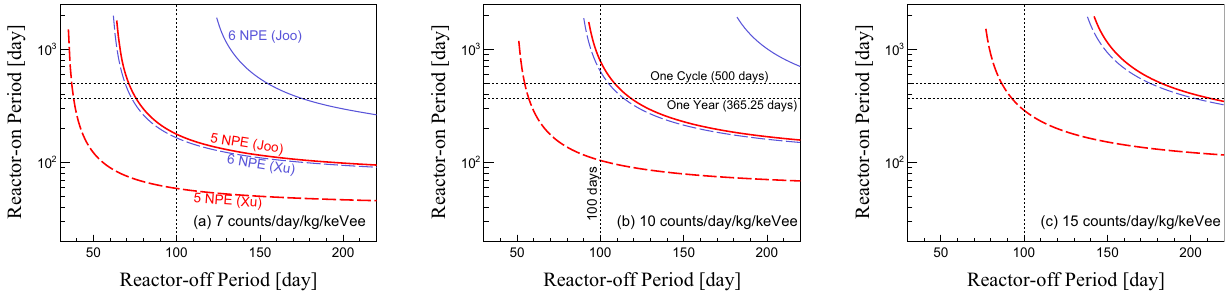
Fig. 27 Discovery sensitivities at 3 σ confidence levels are presented in data exposures of the reactor-on (Y-axis) and reactor-off (X-axis). We vary NPE thresholds from 5 to 6 for two different QF models assuming 7 counts/kg/keV/day ( a ), 10 counts/kg/keV/day ( b ), and 15 counts/kg/keV/day ( c ) background levels